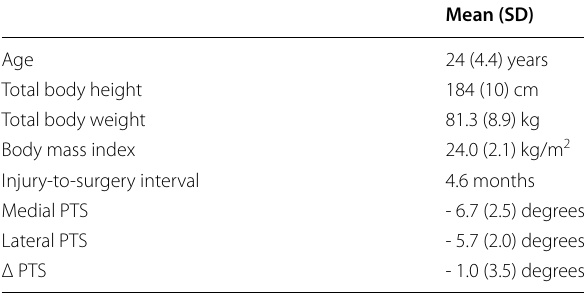
ΔPTS difference between medial PTS and lateral PTS. PTS Posterior tibial slope, = SD Standard deviation Table 2 rTR and ATT during different movements in ACL-deficient, ACL-reconstructed and ACL-intact knees